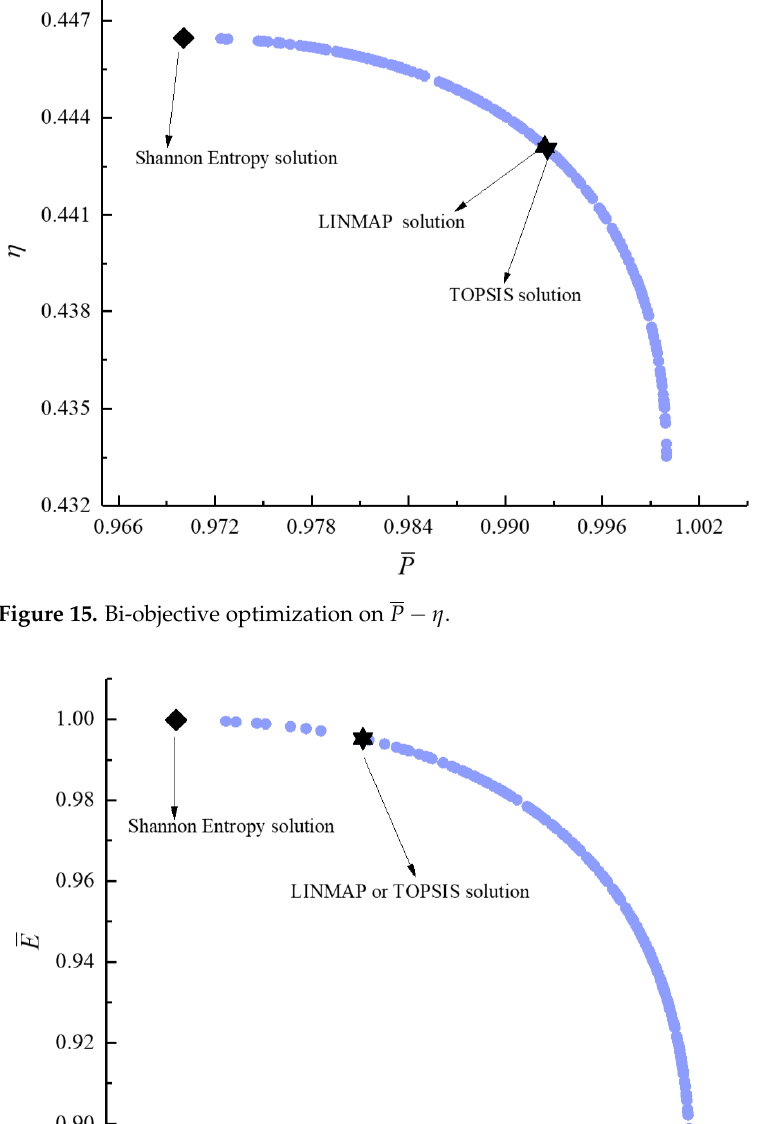
Figure 14. Tri-objective optimization on